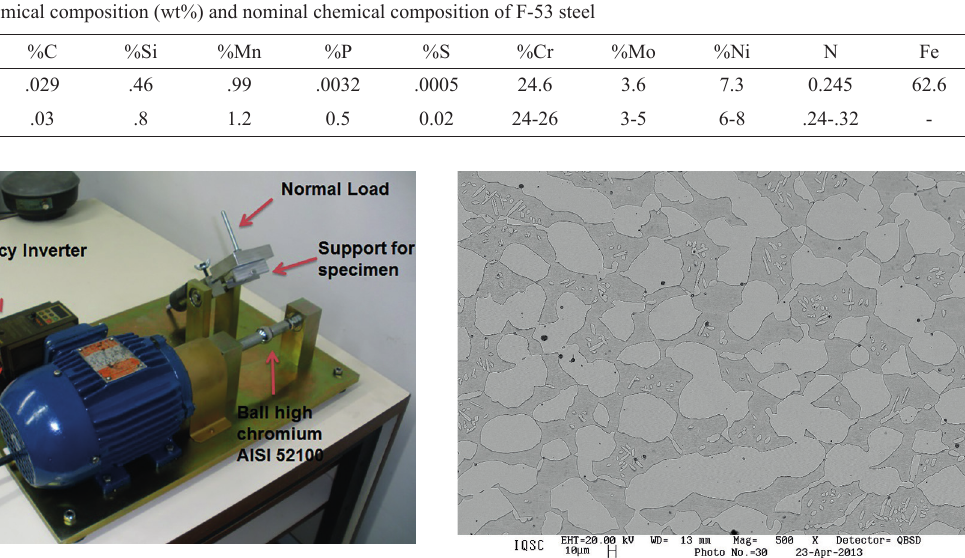
Figure 1: Microwear device.